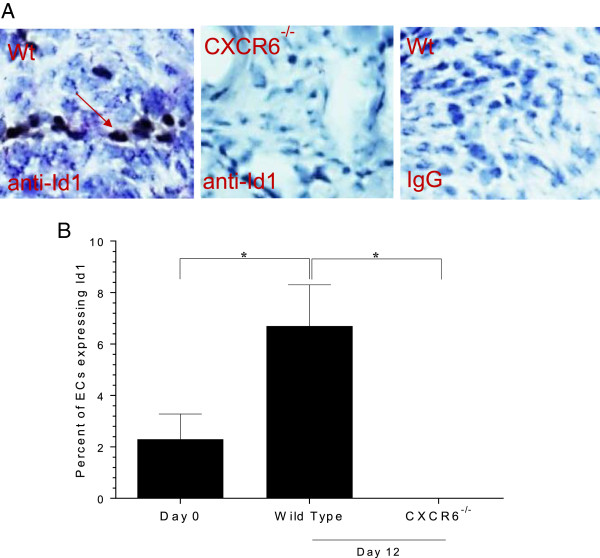
Id1 expression is elevated in Wt, but not CXCR6−/− K/BxN serum-induced mice. Wild type (Wt) and CXCR6−/− mice were induced with K/BxN serum and joint tissue sections were immunostained for Id1. A) Day 12 Wt mice show clear expression of Id1 positive endothelial cells (ECs), whereas CXCR6−/− mice do not. B) The results are graphed and show that day 0 and 12 Wt mice have Id1 expressing endothelial progenitor cells (EPCs) in joint tissue, but Id1 positive cells were not detected in Day 12 K/BxN serum-induced CXCR6−/− mice (n = 10 sections from 10 mice for the Wt groups, and n = 10 sections from four mice in the CXCR6−/− group (400×)).